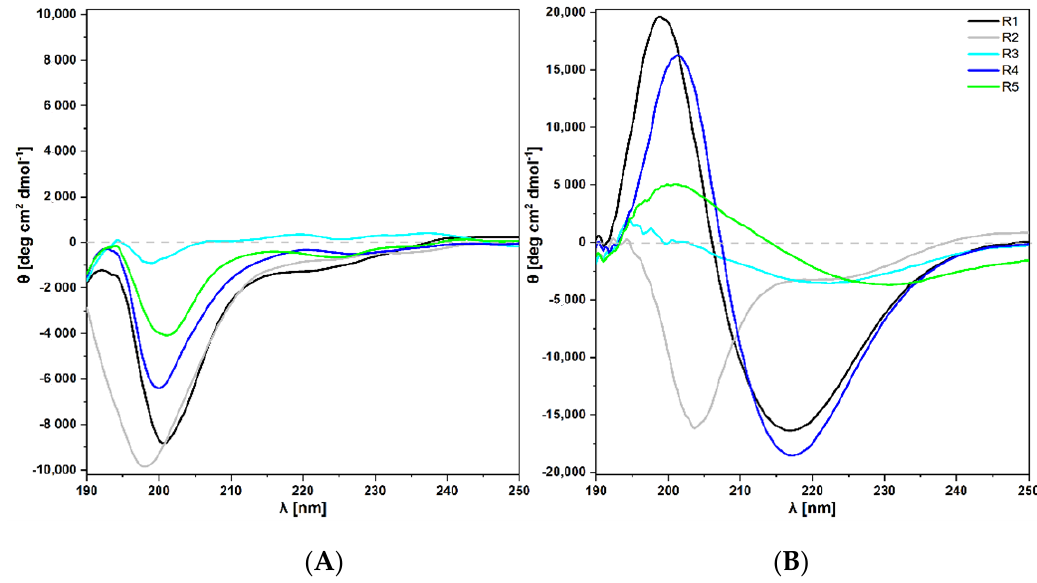
Figure 2. Far-UV CD spectra of CsgA fragments on the day of the dissolving. ( A ) Spectra for E. coli fragments, ( B ) Spectra for S. enterica fragments on the day of the dissolving (final peptide concentration 500 µM).